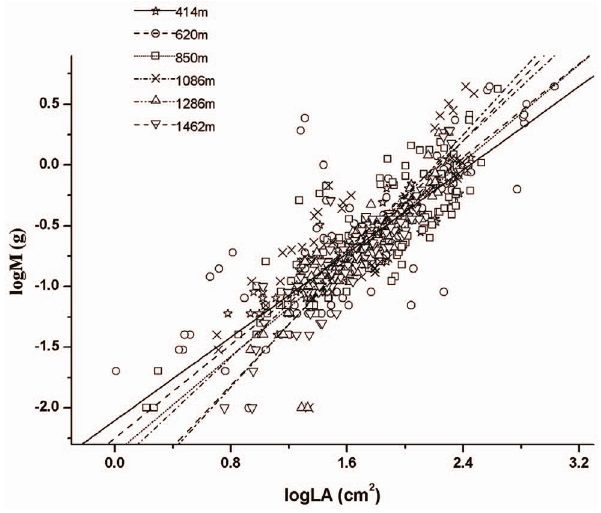
Figure 1. Leaf mass-area relationship at six sites as estimated by RMA